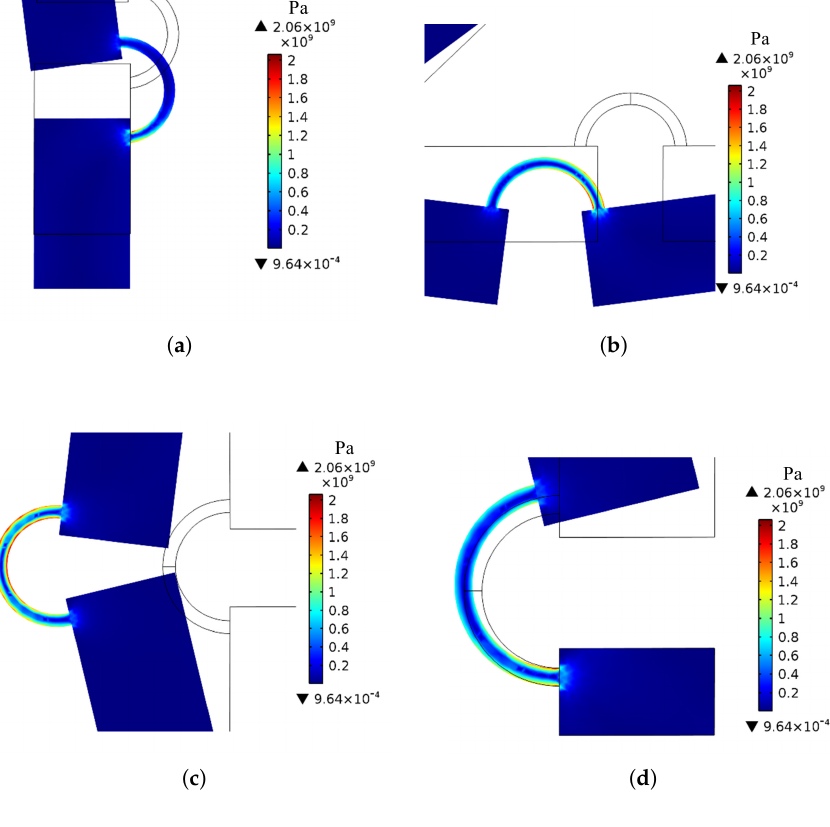
Figure 19. von Mises stress distribution on the most solicited flexure hinges for the maximum input force F m = 5.4 mN: ( a ) hinge B , ( b ) hinge F , ( c ) hinge M , ( d ) hinge M 0 (the labels in Figure 9 are used to designate flexure